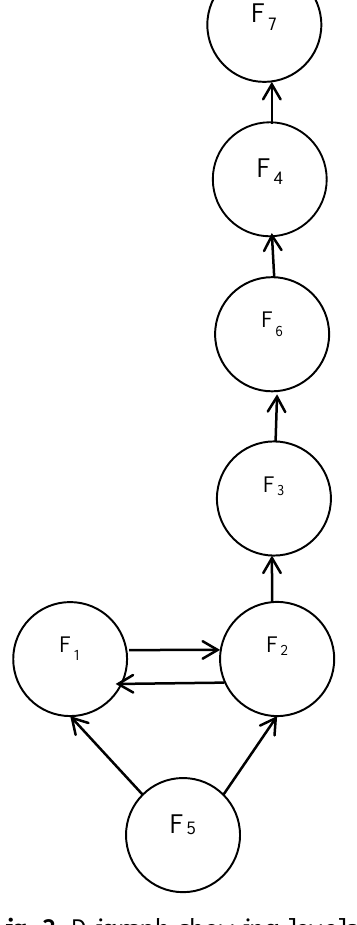
Fig. 3. Digraph showing levels of